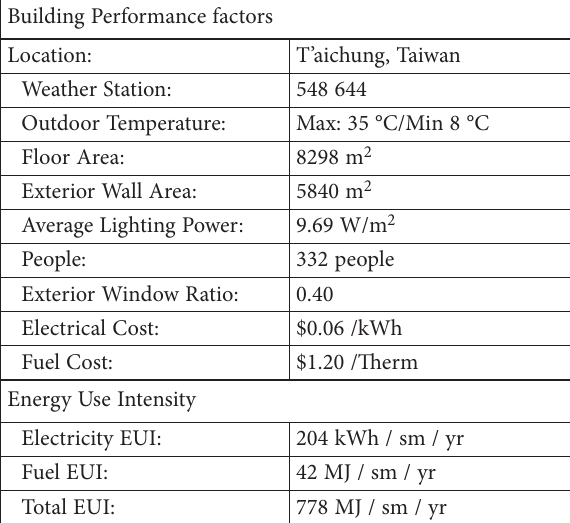
Table 5. Summary of the results of the analysis Building Performance